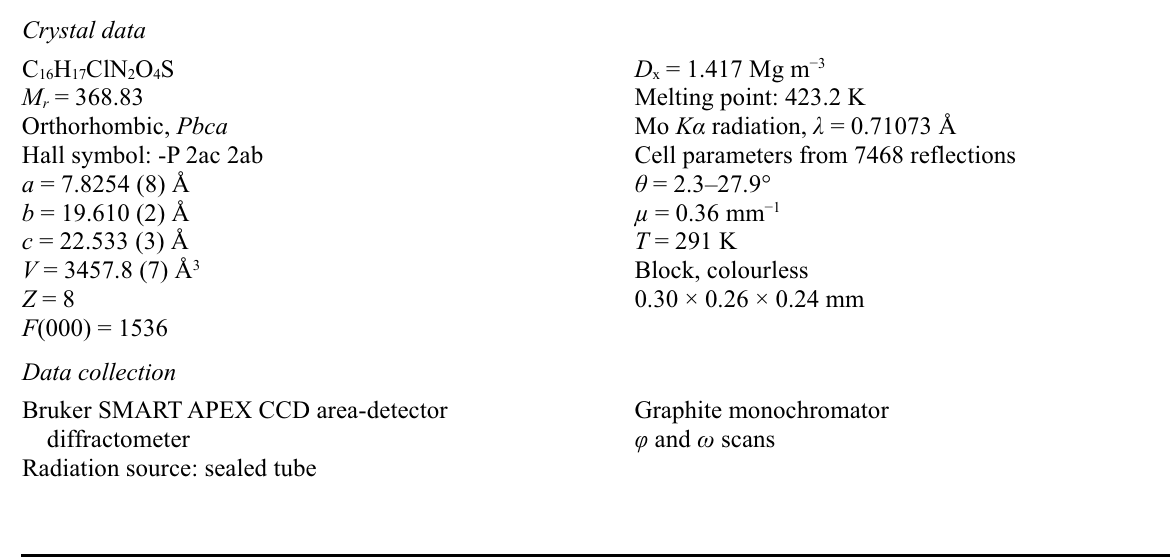
Figure 1 The molecular structure of (I), with atom labels and 30% probability displacement ellipsoids for non-H atoms. N